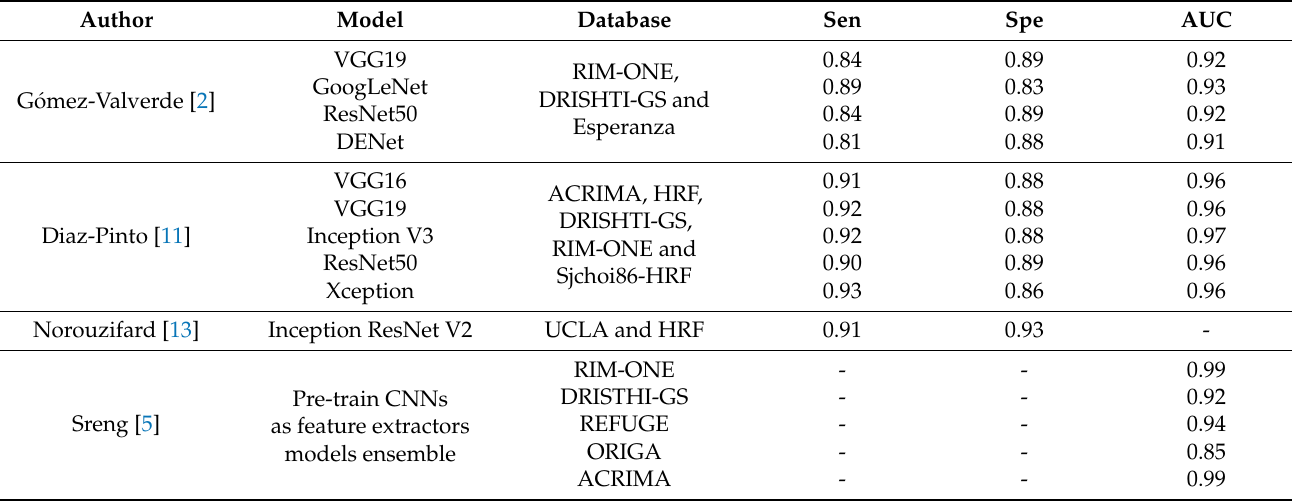
Table 2. Results of state-of-the-art glaucoma classification